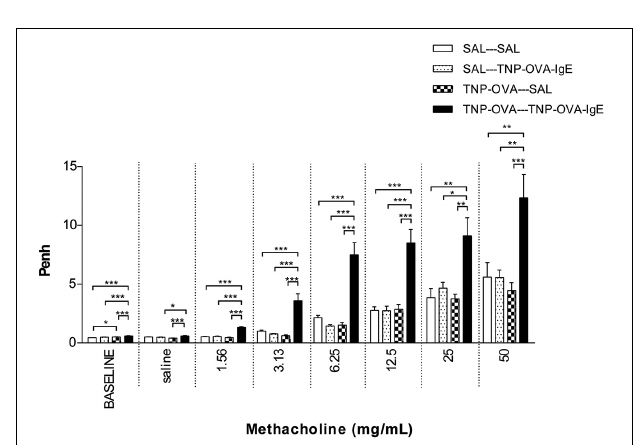
FIGURE 3 | Resistance measurement (R L ) to methacholine in the mild airway inflammation model. Resistance was measured in ventilated mice sensitized with saline or ovalbumin and challenged by aerosol with saline or ovalbumin. Values are expressed as mean ± s.e.m. ∗ P < 0 . 05; using a One-Way ANOVA followed by a Bonferroni post-hoc analysis, n = 7–9 mice/group.